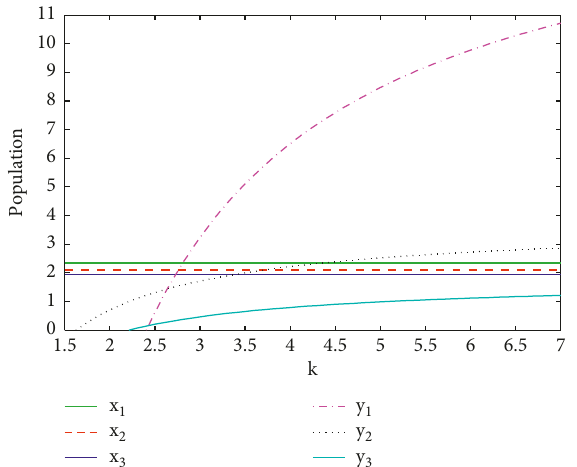
Figure 15: Variation of the system (1) when k � k